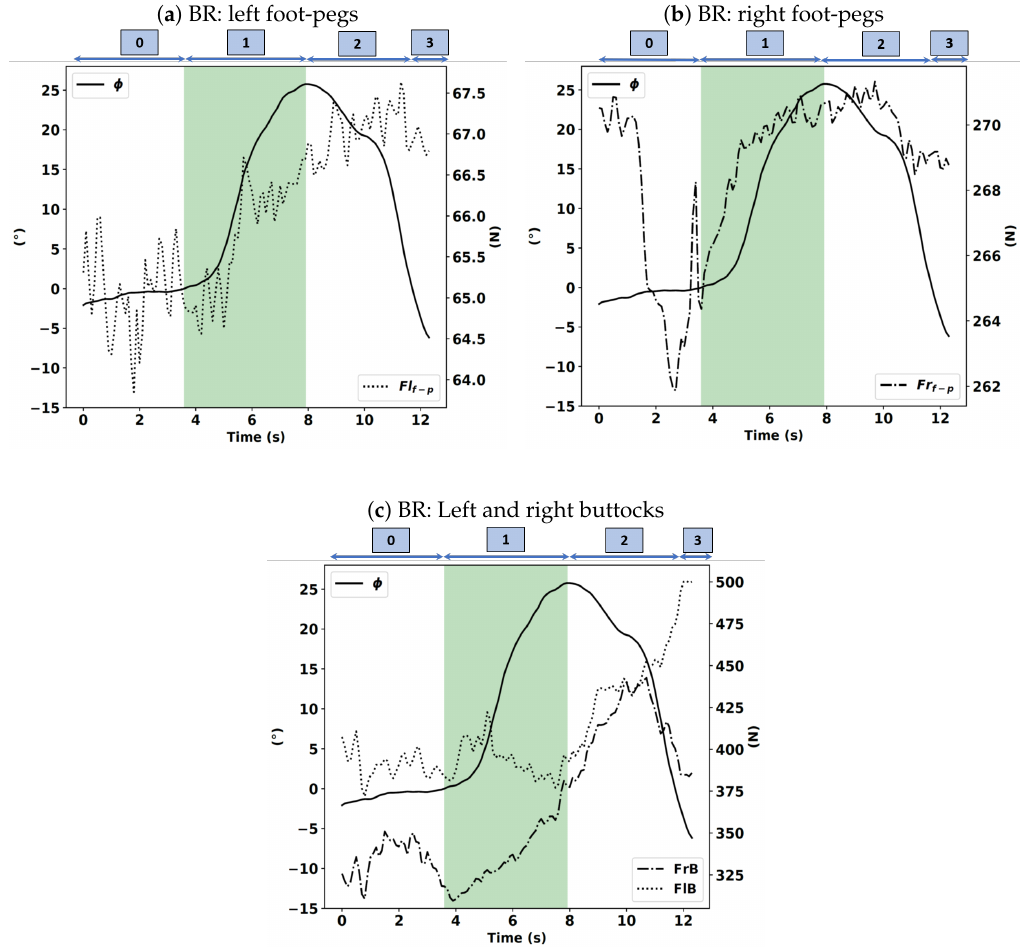
Figure 14. Left and right foot-pegs ( Fl f − p , Fr f − p ), buttocks forces ( FlB , FrB ) expressed in newtons (N) with the roll angle ( φ ) expressed in degrees (°) in the BR